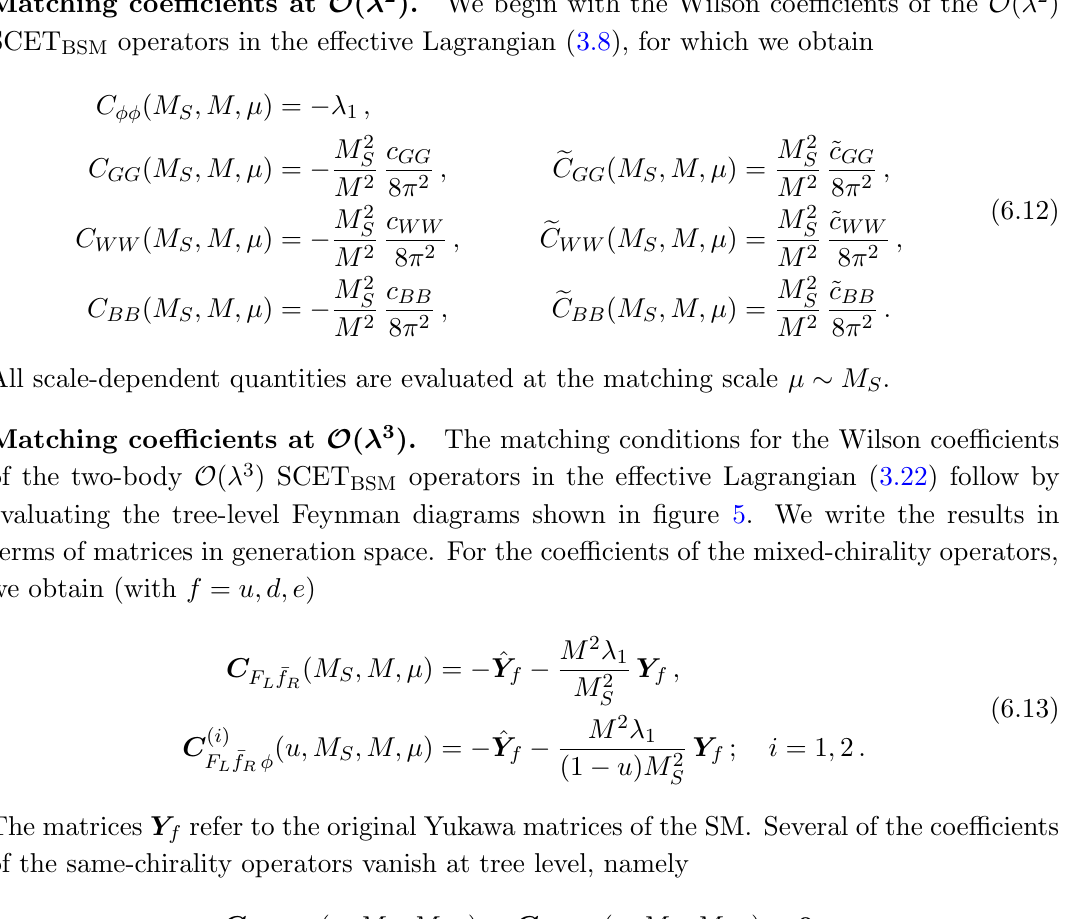
Figure 5 . Diagrams contributing to the tree-level matching conditions for the Wilson coe(cid:14)cients of ( (cid:21) 3 ) operators. The (cid:12)rst two graphs contribute the two terms in (6.13) and (6.16), while the O third diagram generates the coe(cid:14)cients in (6.15) and (6.17). Matching coe(cid:14)cients at O ( (cid:21) 2